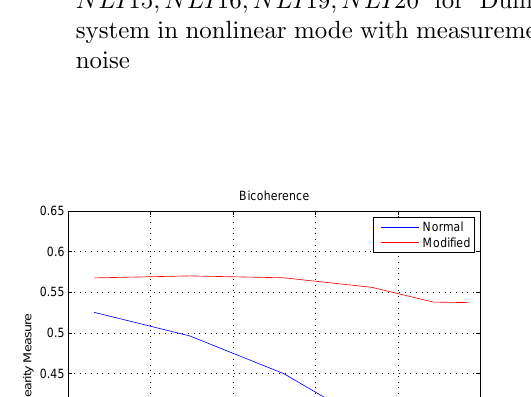
Figure 7: Nonlinearity measure based on indices NLI 15 , NLI 16 , NLI 19 , NLI 20 for Duffing system in nonlinear mode with measurement